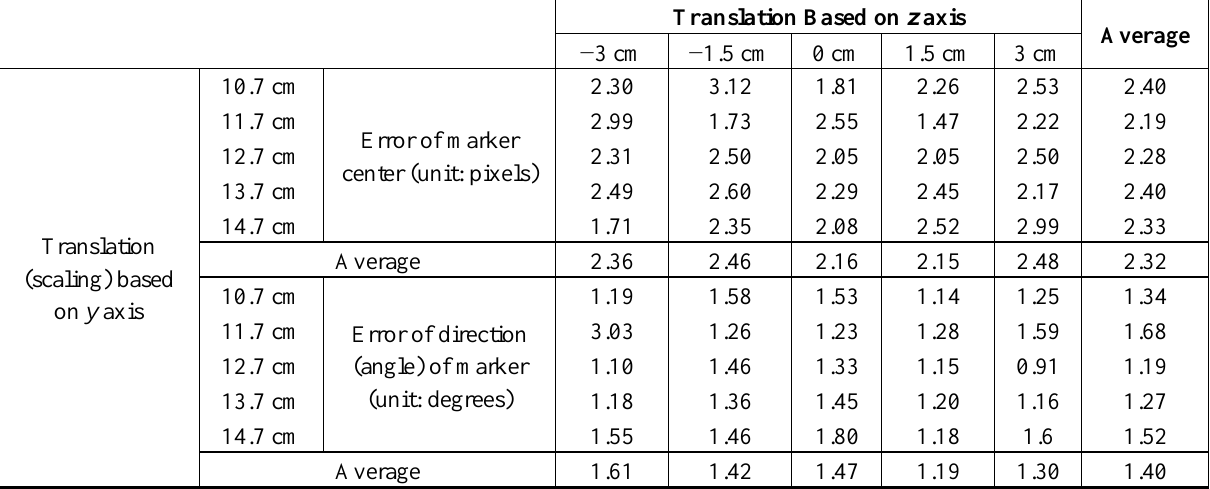
Table 4. Detection error results in case of the translation of device based on y - and z -axes, respectively. Translation Based on z axis